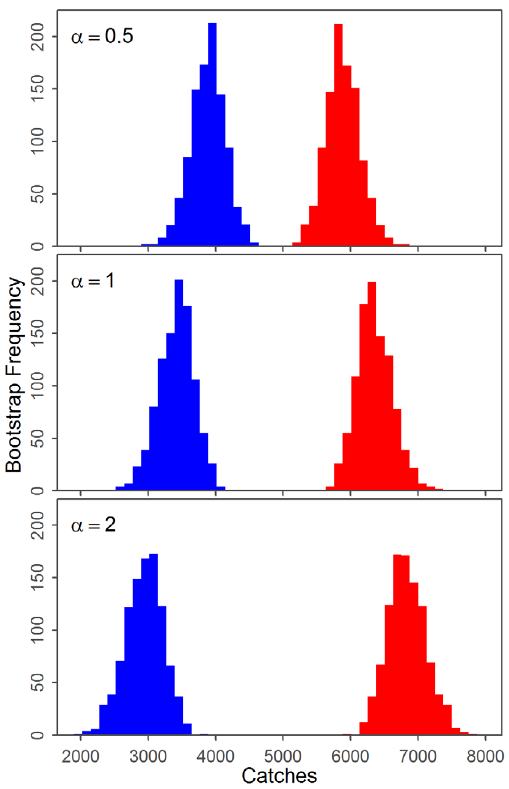
Figure 13. Results of the sensitivity analysis to the conversion between song call frequency and density of whales. The sensitivity to the base case assumption that a ~ 1 to the final results is explored with histograms of the total catches of the ENP (blue) and WNP (red) populations for three levels of a . a is the ratio of the unknown WNP and ENP factors which convert density of whales to song call occurrence.